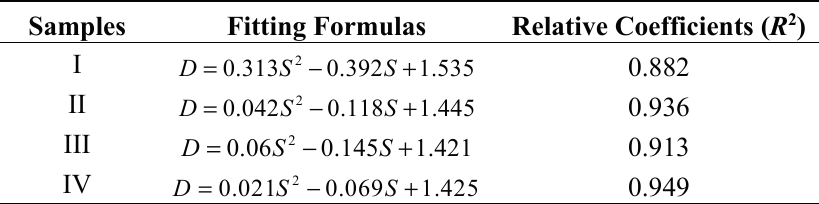
Figure 11. D -values of the four samples under different stresses. ( a ) Sample I; ( b ) Sample II; ( c ) Sample III; ( d ) Sample IV. Table 4. Fitting formulas for the D -value in terms of the